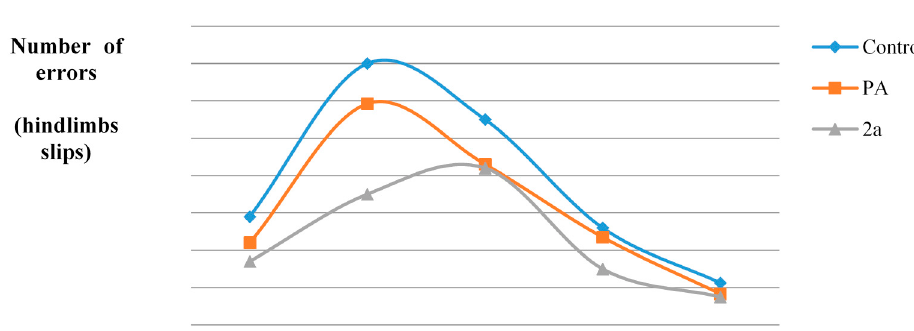
Figure 5. Grid runway (S.D. < 10%).